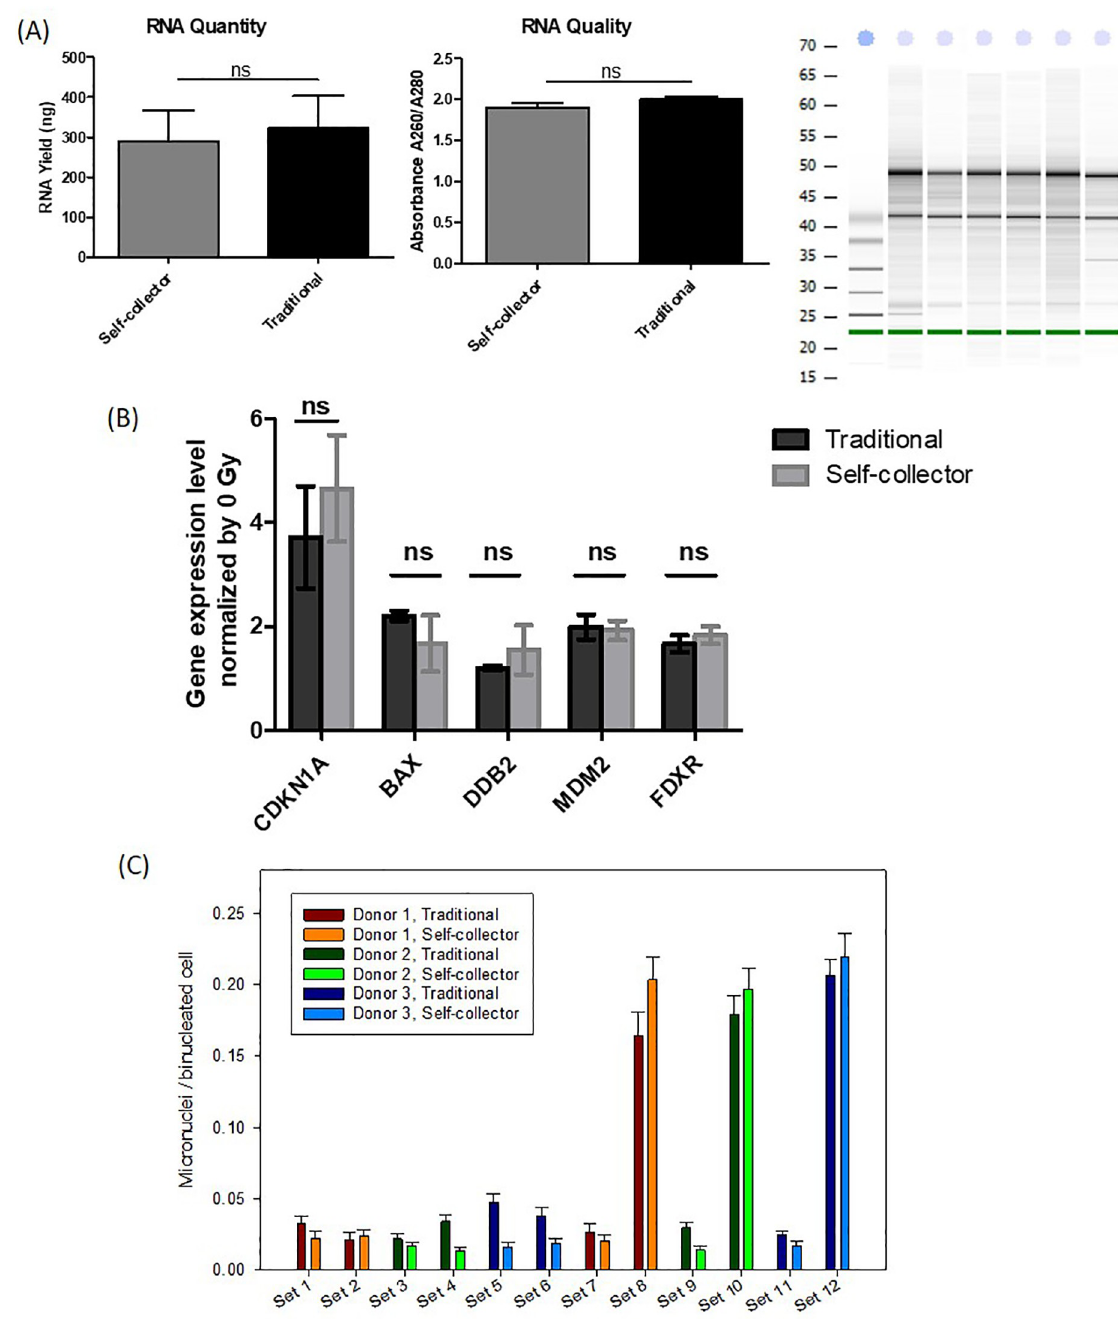
Fig 6. Characterization of self-collected samples for gene expression and cytogenetic biodosimetry assays. (A) Comparison of quantity (left) and quality (middle) of RNA isolated from blood using traditional method and the self-collector, the electropherogram (right) shows integrity of RNA by the self-collectors (RINs = 7.0–8.5, comparable to traditional method); (B) change of gene expression at 3 Gy relative to 0 Gy for real-time qRT-PCR (NS = not significant); (C) Micronuclei per binucleated cell for samples collected by traditional method or the integrated self-collector. The numbers are below 0.05 for all non-irradiated samples, and no significant difference between traditional and self-collector for the irradiated samples.